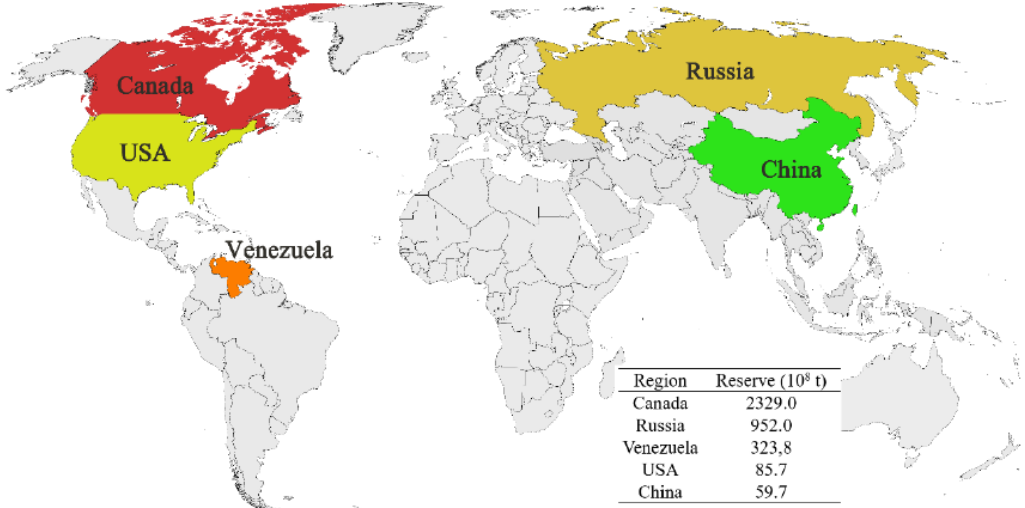
Figure 1. Distribution and reserves of unconventional petroleum oil resources. Reprinted with